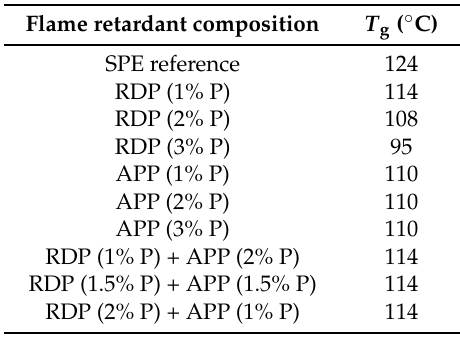
Table 1. Effect of the additive flame retardants on the glass transition temperature ( T g ) of SPE. Flame retardant composition T g ( ◦ C) SPE reference